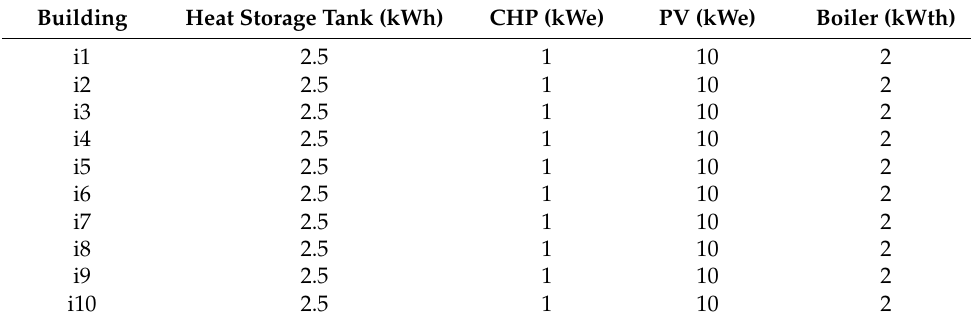
Table 6. Installed capacity of units.